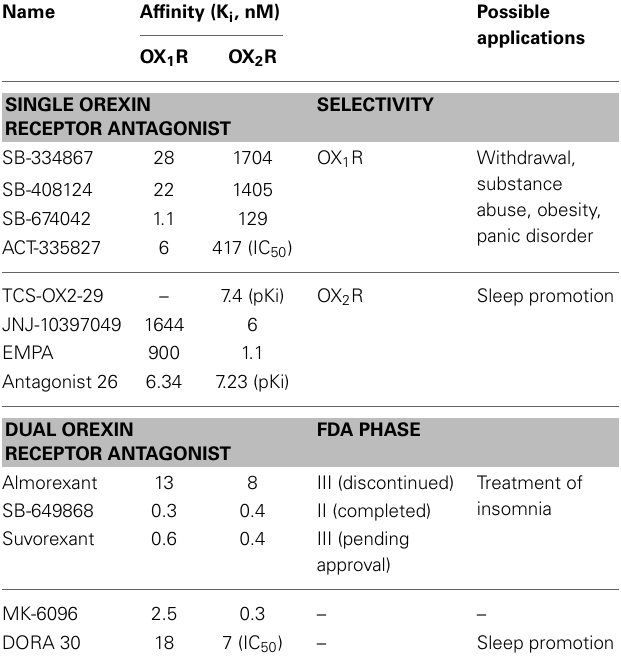
Table 2 | Summary of orexin receptor